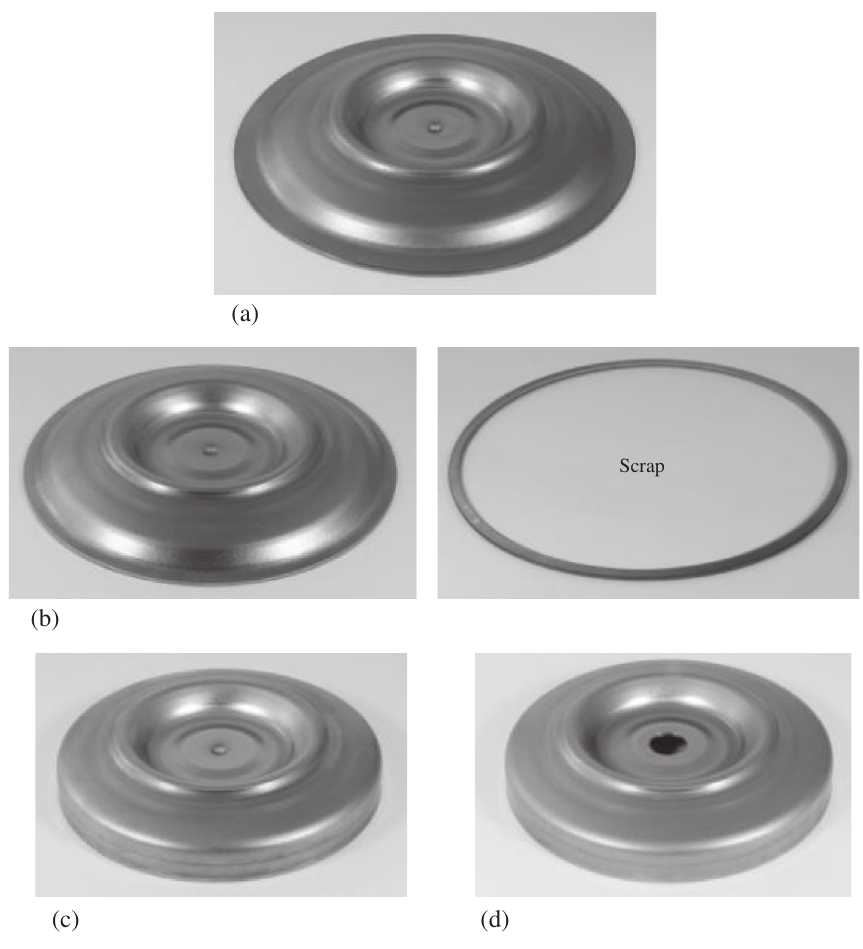
Figure 17. (a) 4th stage, (b) 5th stage, (c) 6th stage and (d) drilled disk.